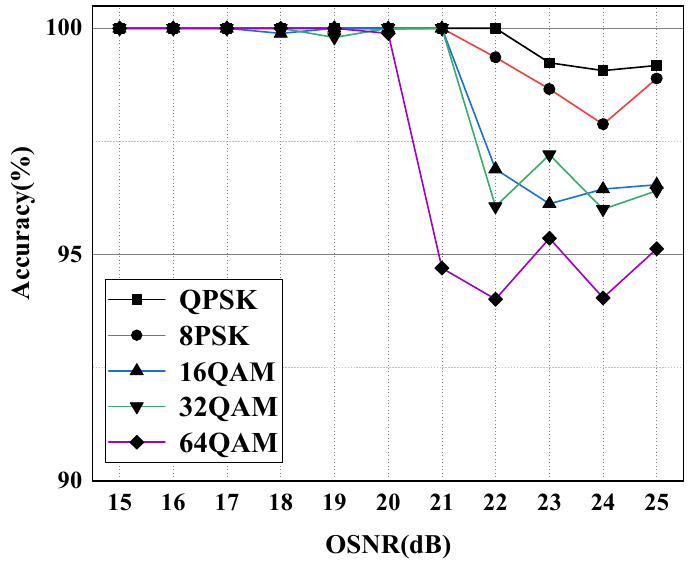
Figure 9. Comparison of OSNR monitoring accuracy curves for di ff erent modulation formats.